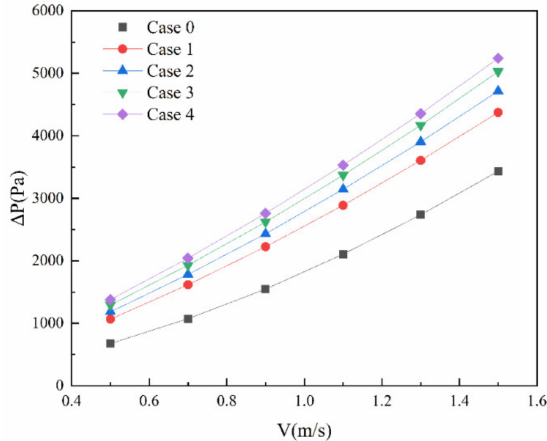
Figure 5. Pressure drop of Cases 0–4 at different inlet